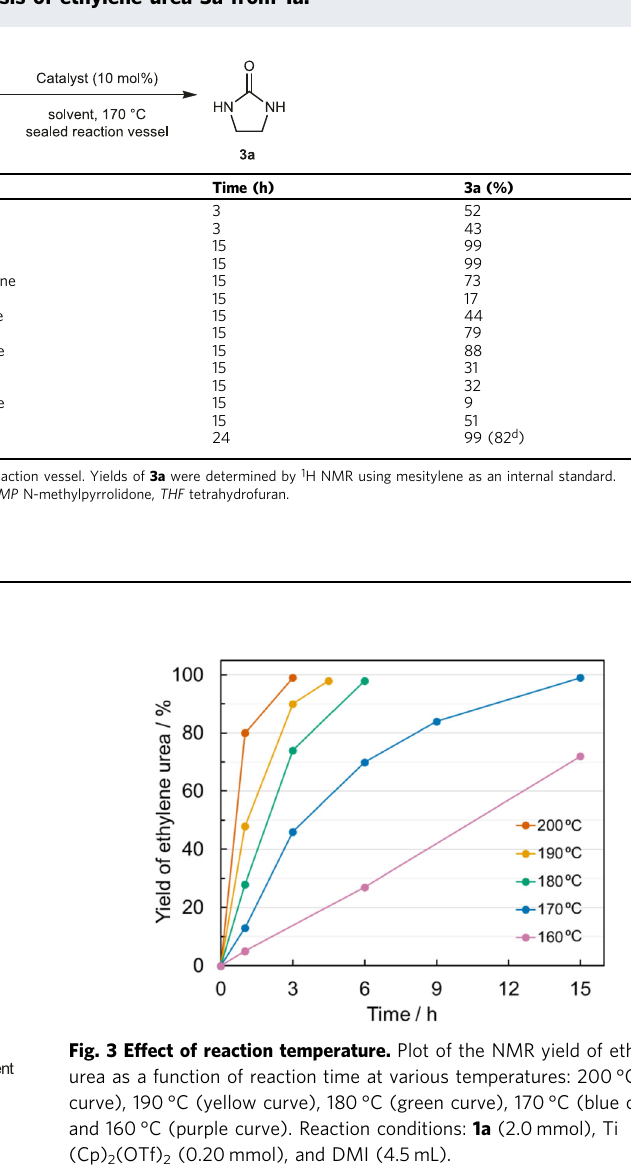
Table 2 Optimization of reaction conditions for the synthesis of ethylene urea 3a from 1a.